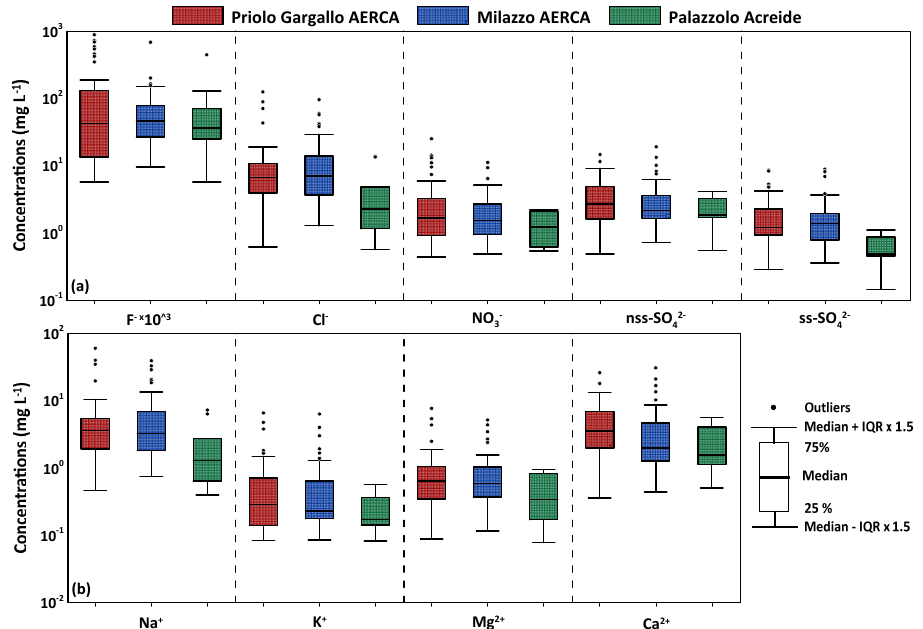
Figure 8. Major anions ( a ) and cations ( b ) concentrations (mg L − 1 ) for Priolo Gargallo AERCA, Milazzo AERCA, and Palazzolo Acreide background area.